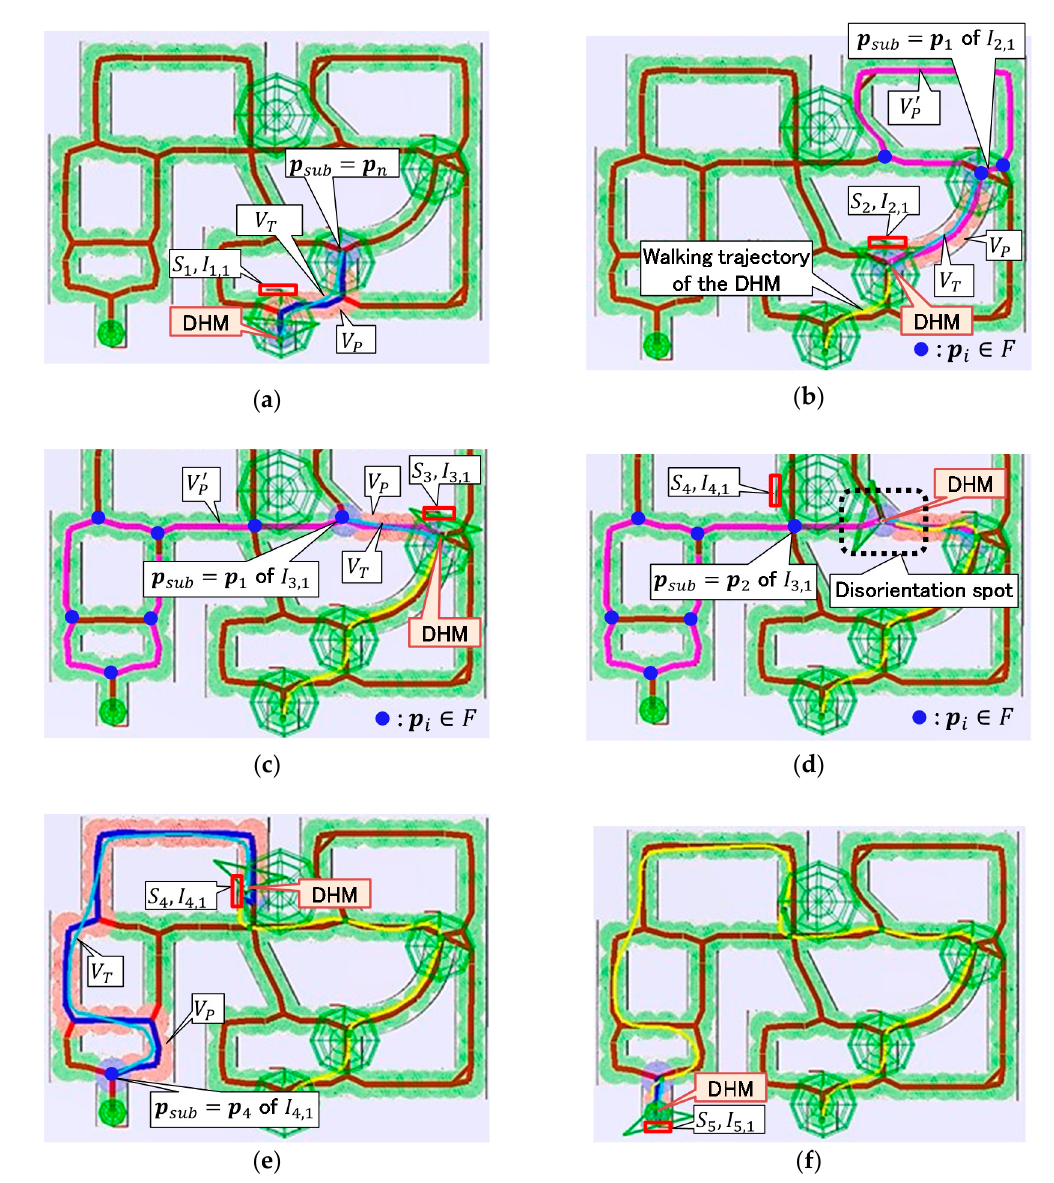
Figure 11. Evaluation results of ease of wayfinding in virtual maze (red lines: graph edges, blue lines: graph edges on V P , cyan lines: V T , yellow lines: walking trajectory of DHM, purple lines: graph edges on V (cid:48) ): ( a ) Wayfinding in accordance with S 1 ; ( b ) wayfinding in accordance with S 2 P